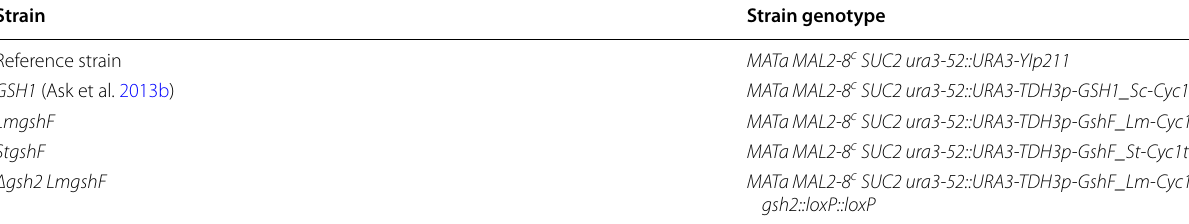
Strains were stored in 80 o C glycerol (30% v/v) YPD stocks (Yeast extract 10 g L − 1 , Peptone 20 g L − 1 and glucose 20 g L − 1 ). Before every experiment, agar plates − + were prepared by streaking the culture onto a YPDA plate (Yeast extract 10 g L − 1 , Peptone 20 g L − 1 and glucose 20 g L − 1 , agar 20 g L − 1 ) and incubated at 30 °C for 48 h, to obtain single colonies